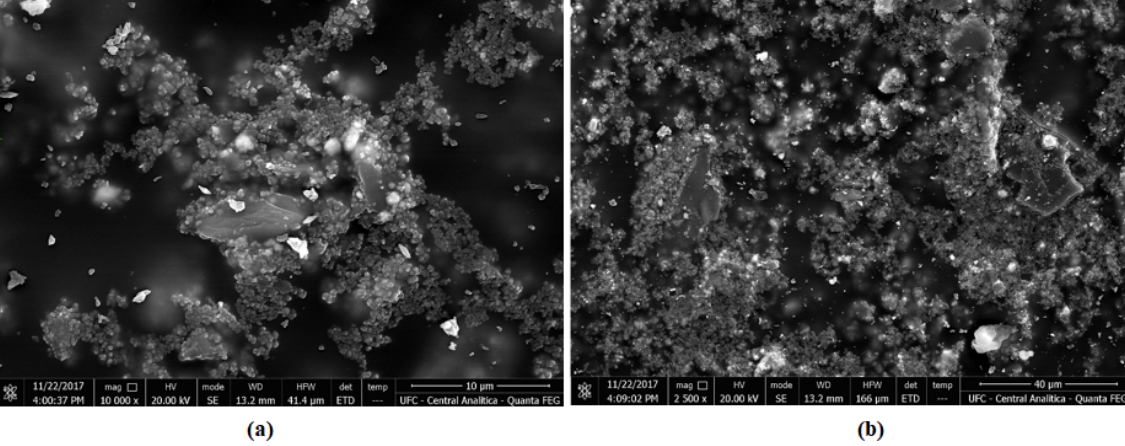
Figure 6: Micrograph of the selective surface sample of 50% titanium oxide – 50% granite powder, with magnification factor of: (a) 10000x and (b) 2500x.